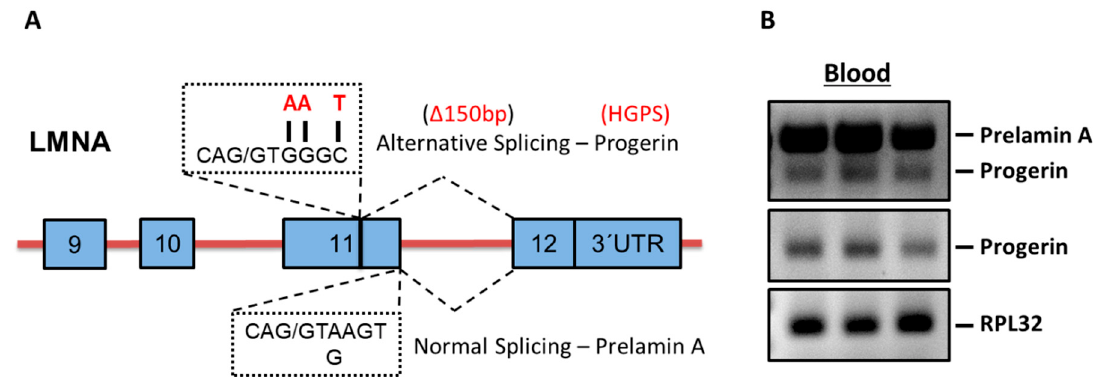
Figure 1. Detection of progerin mRNA expression in human blood cells. ( A ). Schematic diagram showing the cryptic splicing site as well as the three most common mutations (letters in red) in exon 11 leading to alternative splicing and progerin mRNA expression. Below the consensus donor splice sequences at the end of exon 11 for normal splicing of LMNA is depicted. ( B ). RT-PCR (Polymerase Chain Reaction) analysis from three human blood samples utilizing set of primers spanning exon 9 and exon 12 detecting both prelamin A and progerin (upper box), primers specifically detecting progerin (exon 11 and exon 12, middle box) and RPL32 as a housekeeping gene (lower